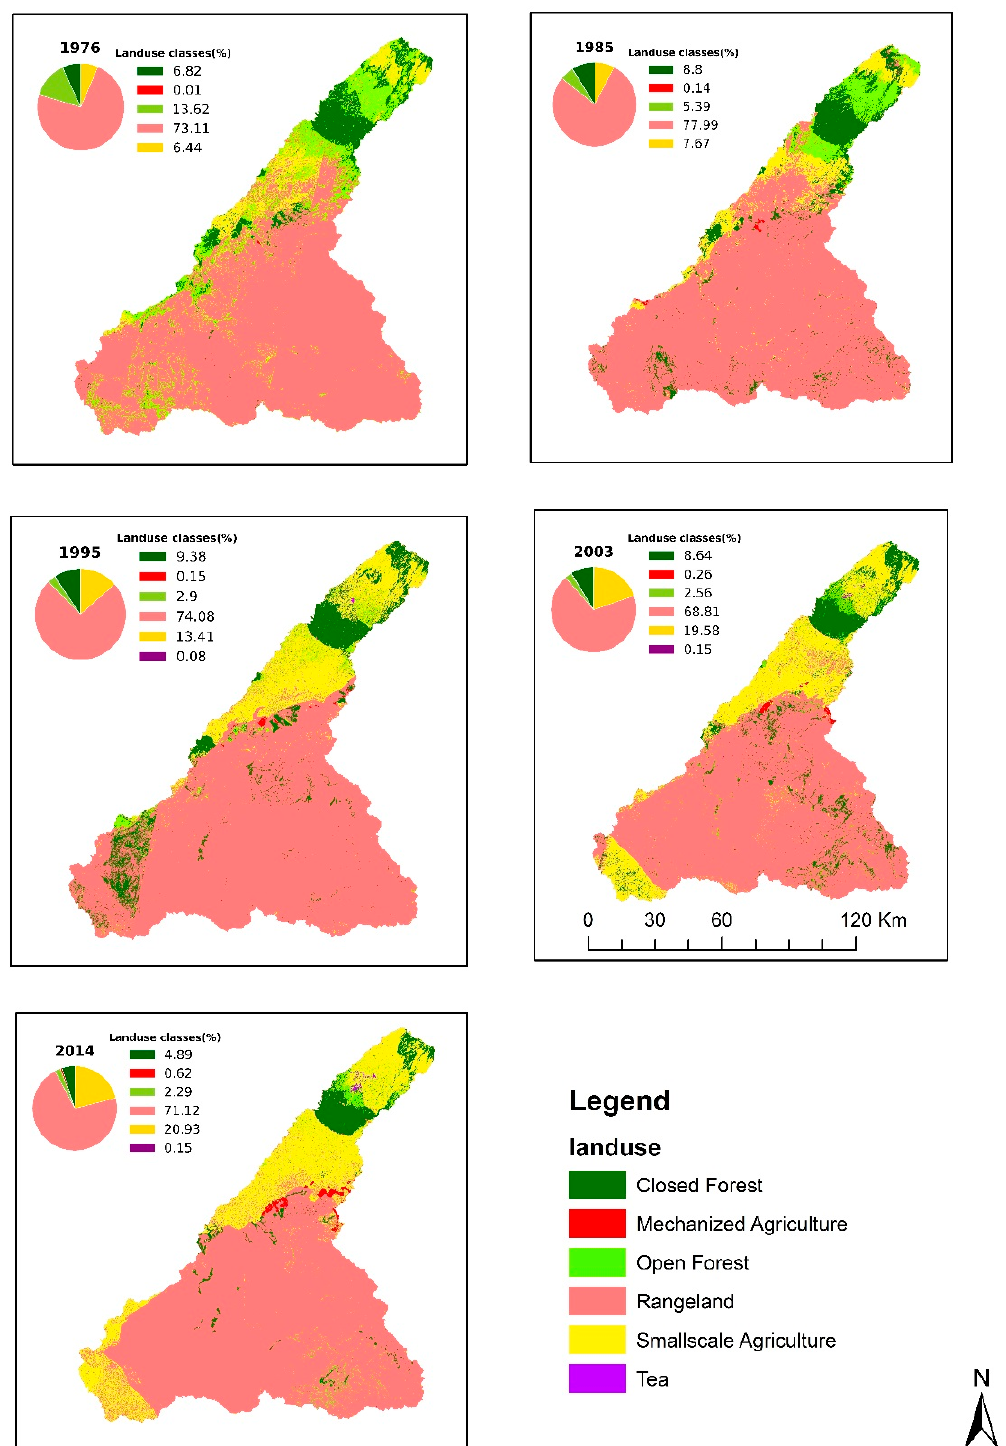
Figure 2. Land-use/cover maps of the Mara River Basin for years 1976, 1985, 1995, 2003, and 2014.